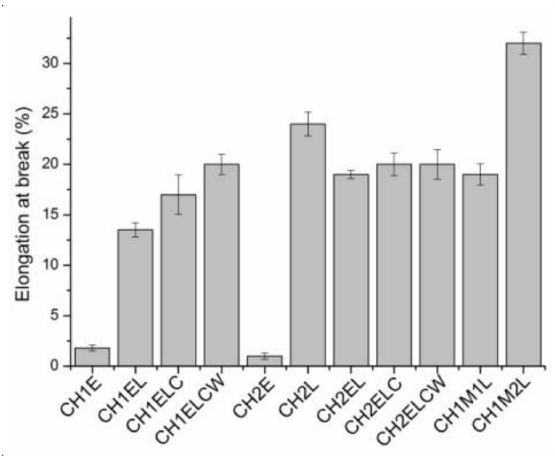
Figure 6. Elongation at break for chitosan/starch-based